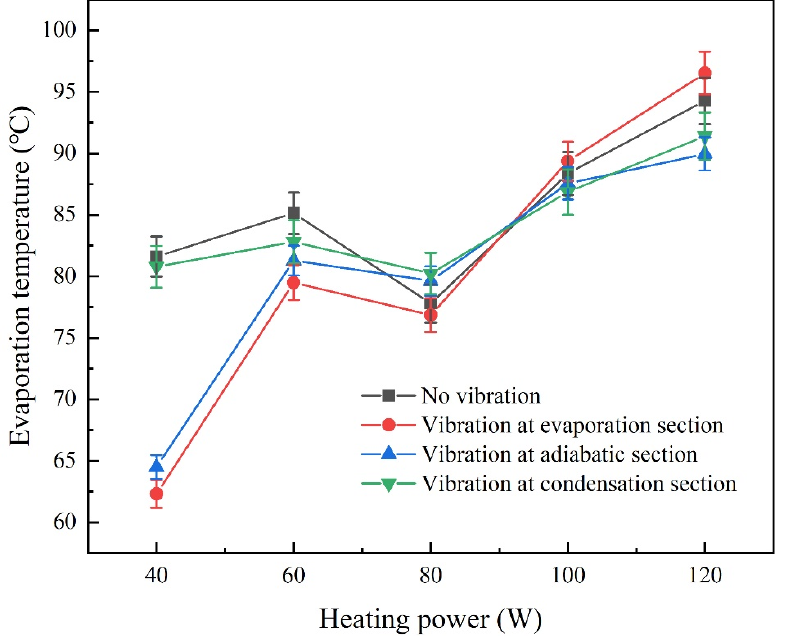
Figure 4. Influence of different vibration positions on the temperature at the evaporation section of the PHP under different heating power levels.